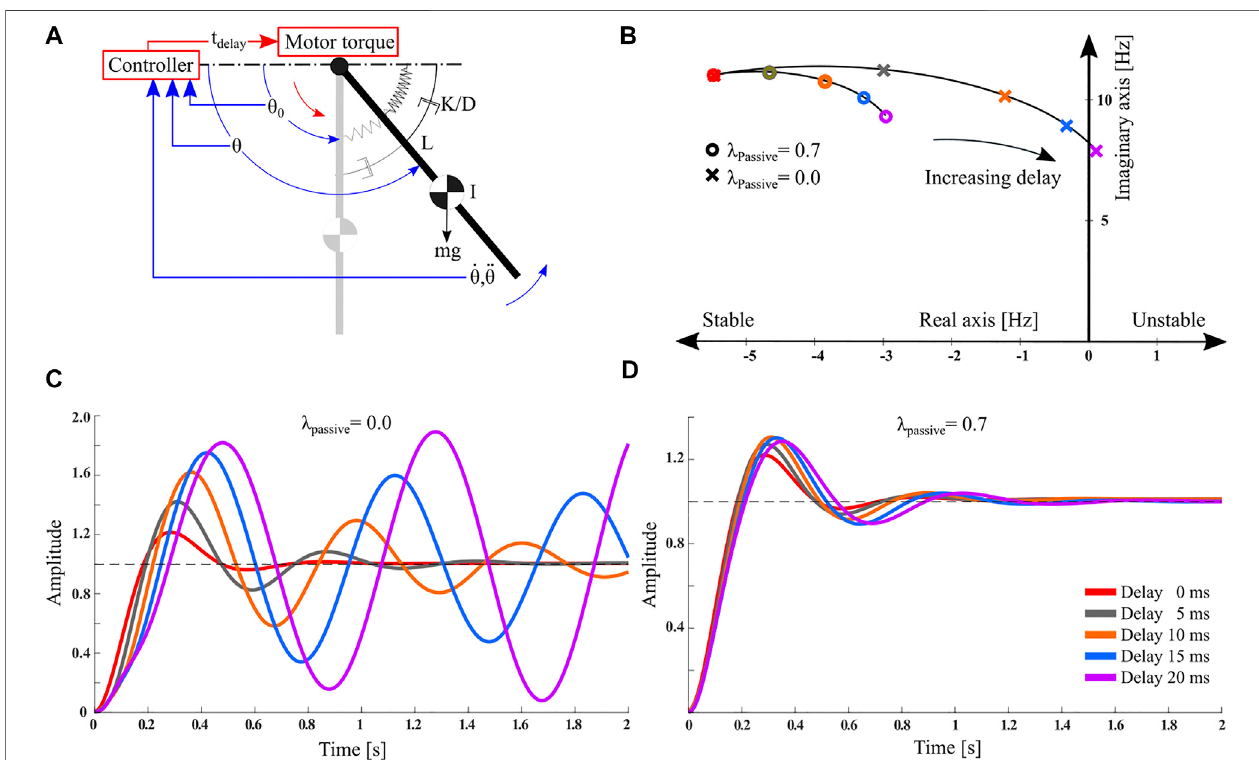
FIGURE4| Simulationresultsofasimpli fi ed,single-linkpendulummountedtoaparallelmotor-springcombination (A) .Parametersareprovidedin Section2.1 . (B) Graphical poleanalysisoftheactuatedpendulum.The effects of varyingdelayand compliance ratios on thesystem stability areshown. (C) The system ’ sstep response for varying delays with λ passive (cid:1) 0 . 0, and (D) λ passive (cid:1) 0 . 7. The hybrid parallel compliance controller ( λ passive (cid:1) 0 . 7) is stable for all tested delays, and performs better compared to fully active actuation ( λ passive (cid:1) 0 . 0).